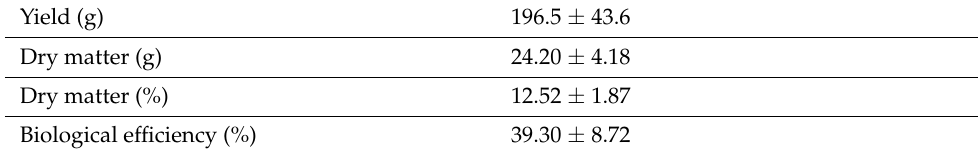
Table 1. The yield, dry matter and biological efficiency (BE) of P. djamor cultivated on EMS. Yield (g) 196.5 ± 43.6 Dry matter (g) 24.20 ± 4.18 Dry matter (%) 12.52 ± 1.87 Biological efficiency (%)